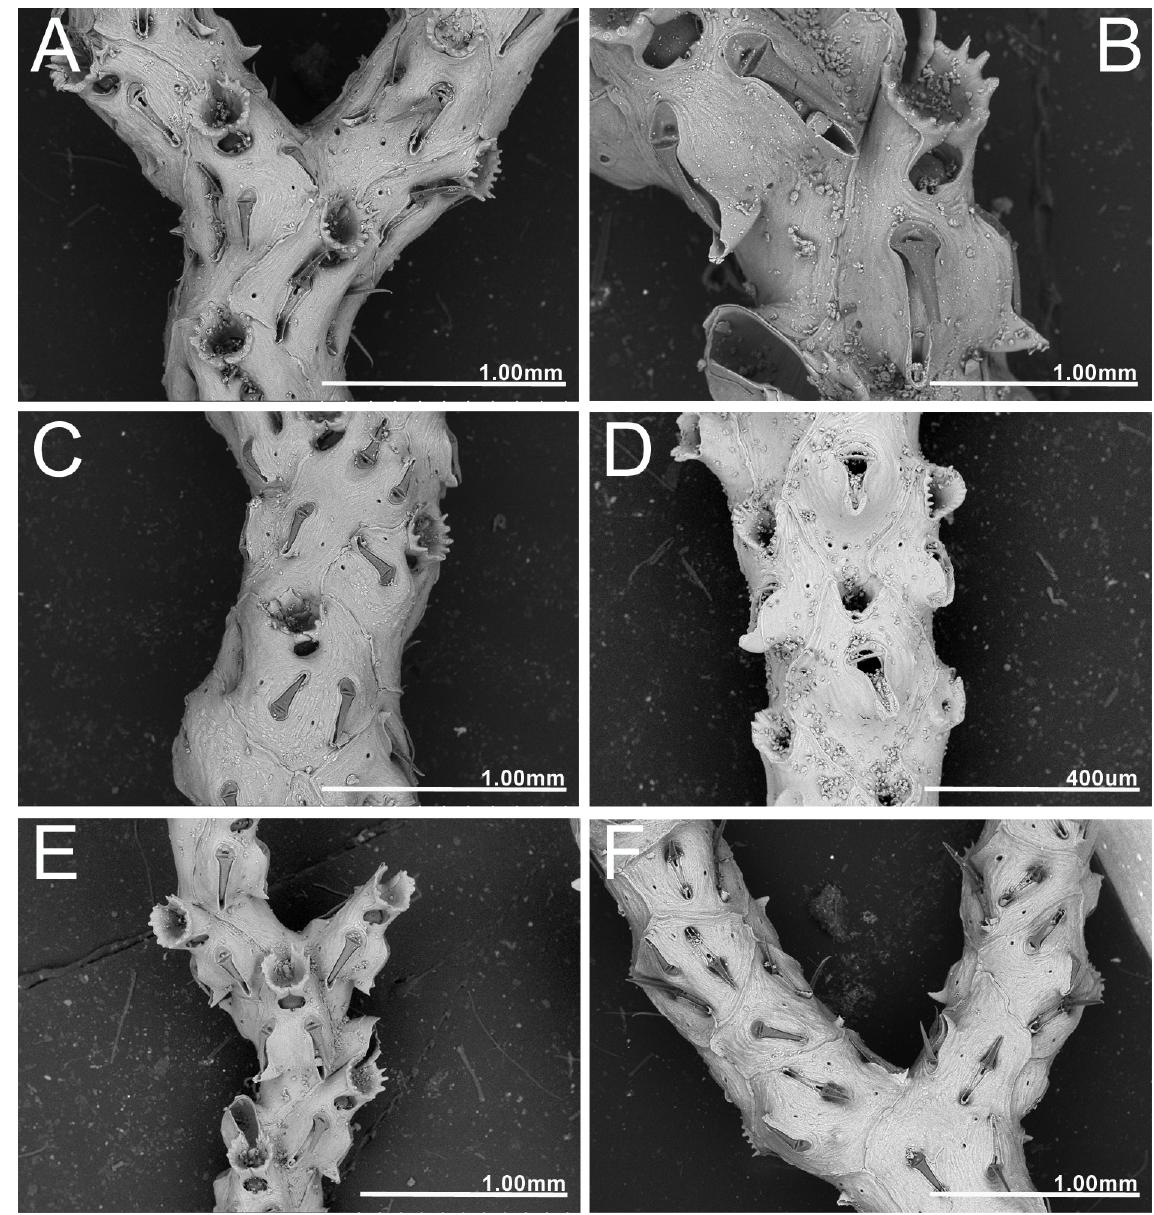
Fig. 4. Schizoretepora calveti d’Hondt, 1975, lectotype (MNHN-IB-2008-7565). A . Colony view. B . Detail of aperture and avicularia. C . Young autozooids and avicularia in frontal view. D . Older autozooids and avicularia in frontal view. E . Ovicellate zooids. F . Abfrontal view with